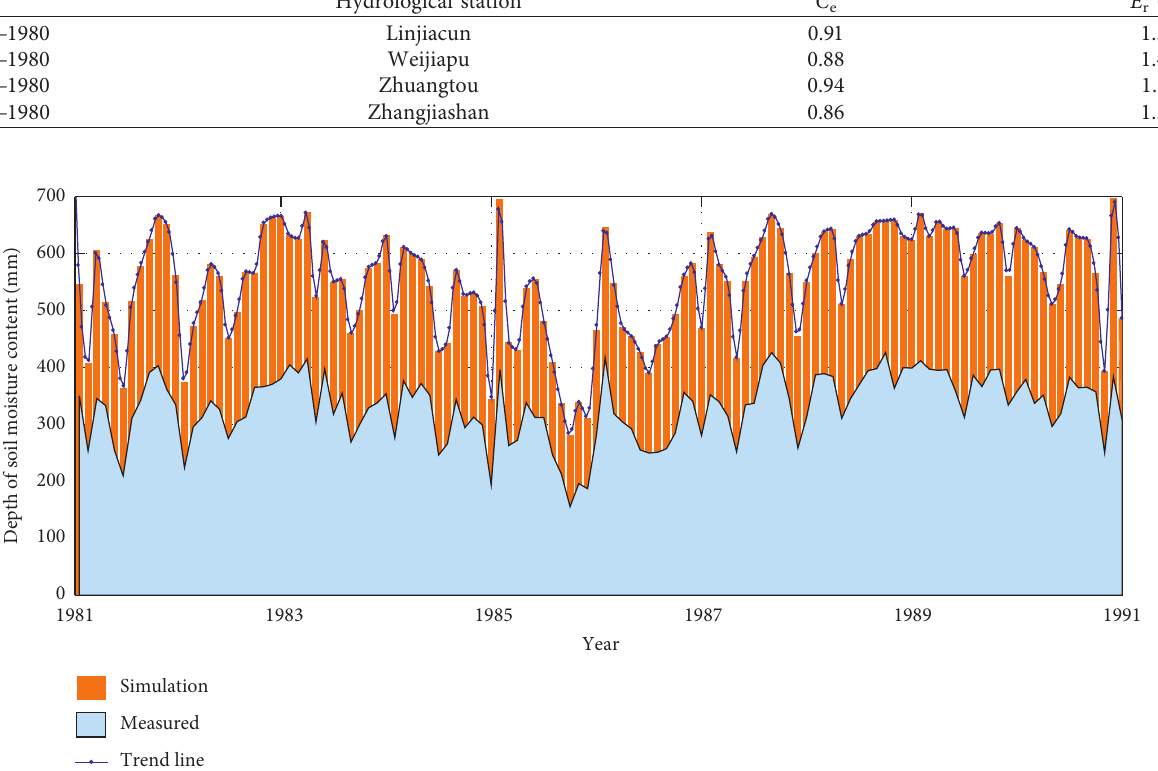
Figure 5: Comparison of measured and simulated soil moisture